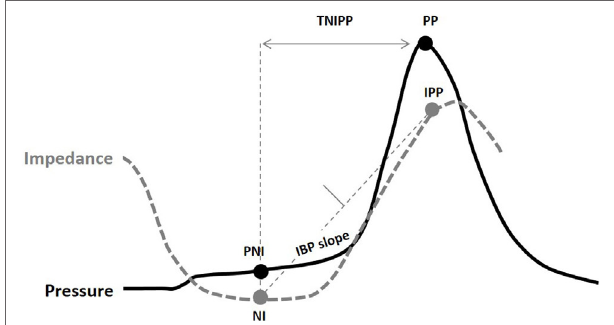
FigURe 2 | Pressure flow analysis metrics indicated on a combined pressure (black) and impedance (gray) line plot [Omari et al. (24)]. Abbreviations stand for NI, nadir impedance; PP, peak pressure; IPP, impedance at peak pressure; PNI, pressure at nadir impedance; IBP-slope, intrabolus pressure slope; TNIPP, time from nadir impedance to peak pressure.